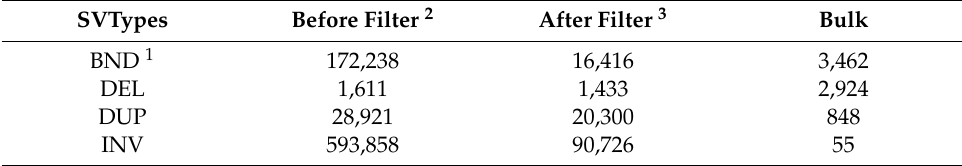
Table 3. The number of structural variations discovered from sequencing